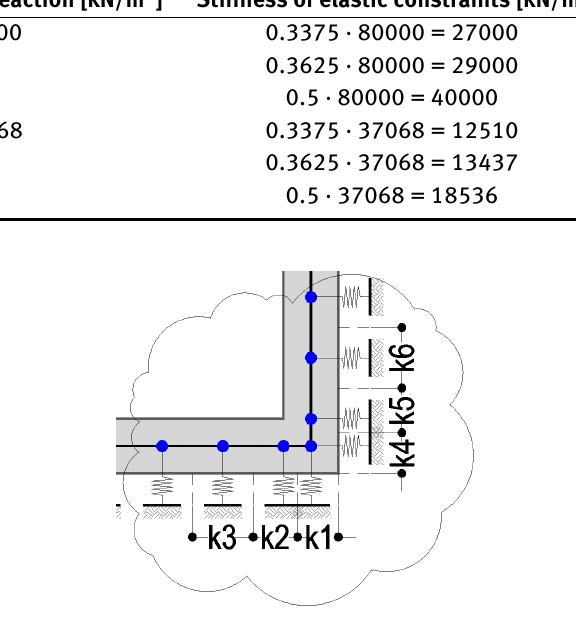
Figure 4: Location of elastic